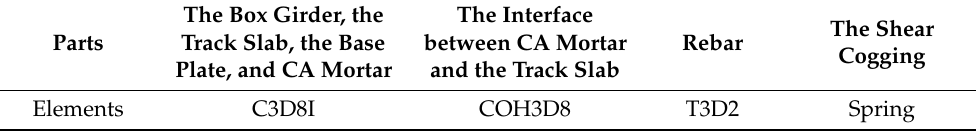
Table 4. Elements of finite-element